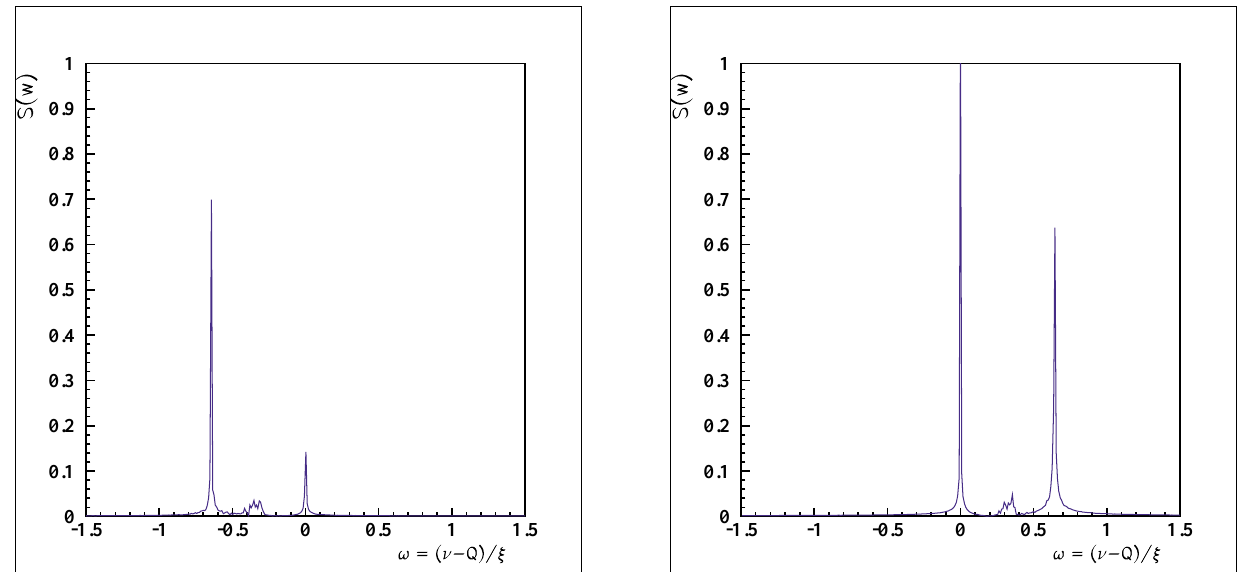
FIG. 9. (Color) Spectrum of the vertical (left) and horizontal (right) centroid motion for long-range collisions with horizontal sepa- ration L x (cid:1) 10.0 (in units of s x ) and no head-on collision ( 2 15 turns, N (cid:1) 10 4 macroparticles). The tune shifts due to long-range collisions have opposite signs in the two transverse planes. The coherent p mode is at twice the incoherent tune shift.